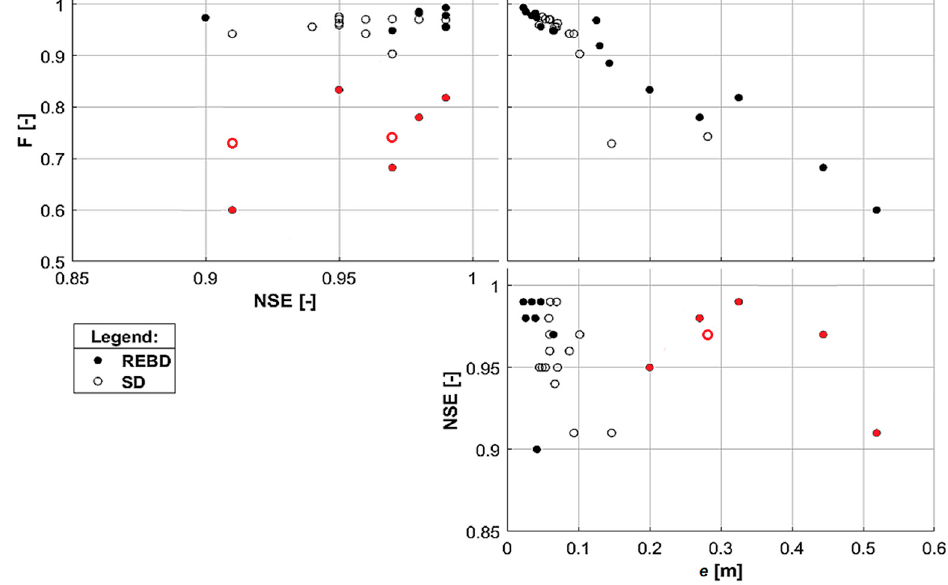
Figure 10. Scatter plot of the good fit criteria for the runoff series NSE and the comparison criteria for the online and offline flood maps Fit Statistic F and average absolute error in water depth e . The exceptions with high NSE values but poor F and e performances are marked in red.